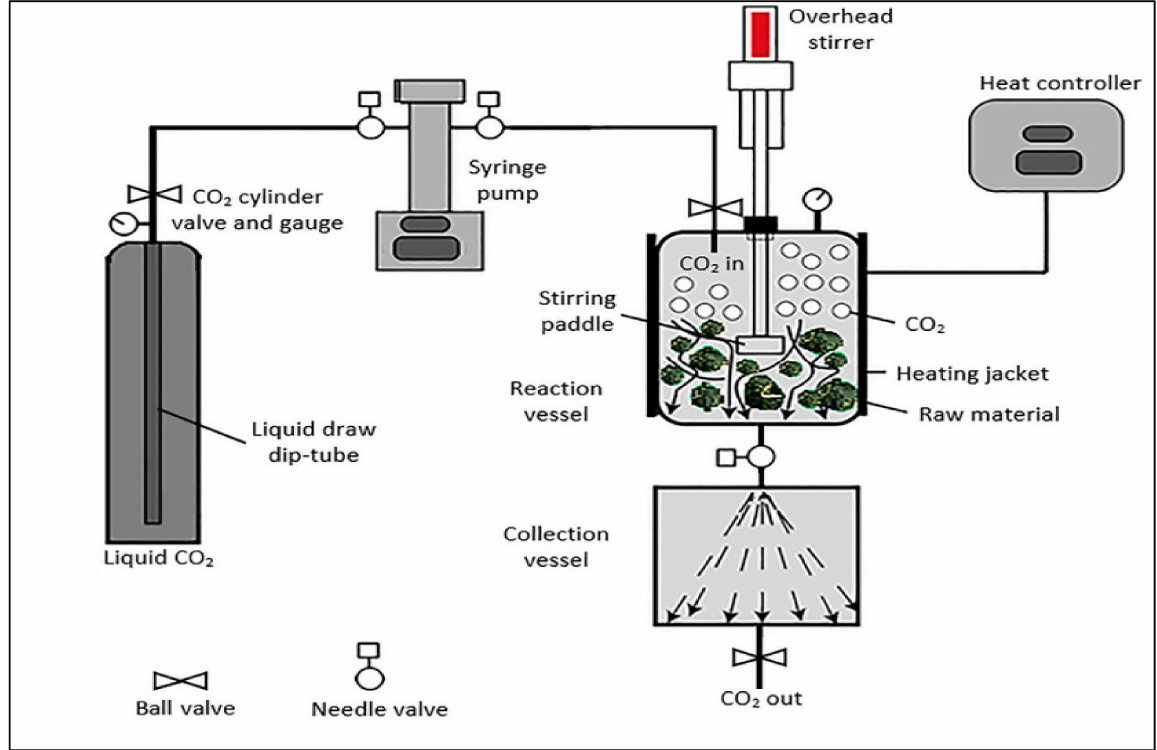
Figure 5. Supercritical fluid-extraction process. Adopted from